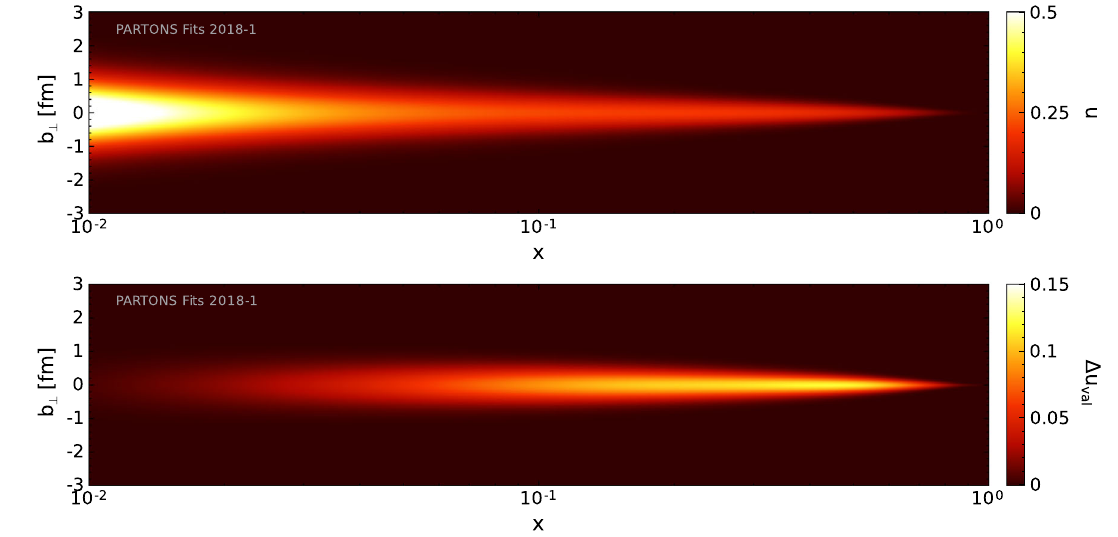
Fig. 15 Position of up quarks in an unpolarized proton (upper plot) and longitudinal polarization of those quarks in a longitudinally polarized proton (lower plot) as a function of the longitudinal momentum fraction x . For the lower plot only the valence contribution is shown